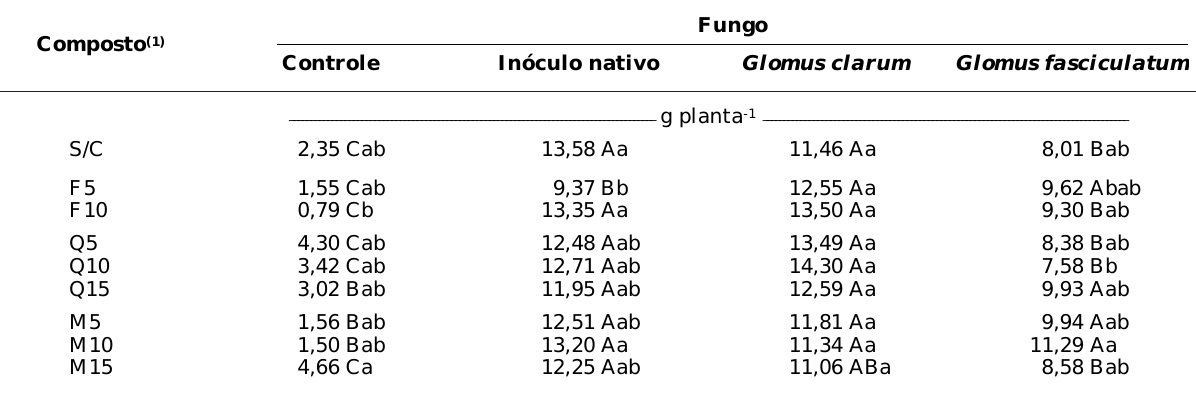
Quadro 3. Produção de matéria seca da parte aérea das mudas de maracujazeiro amarelo, após o transplantio para substrato